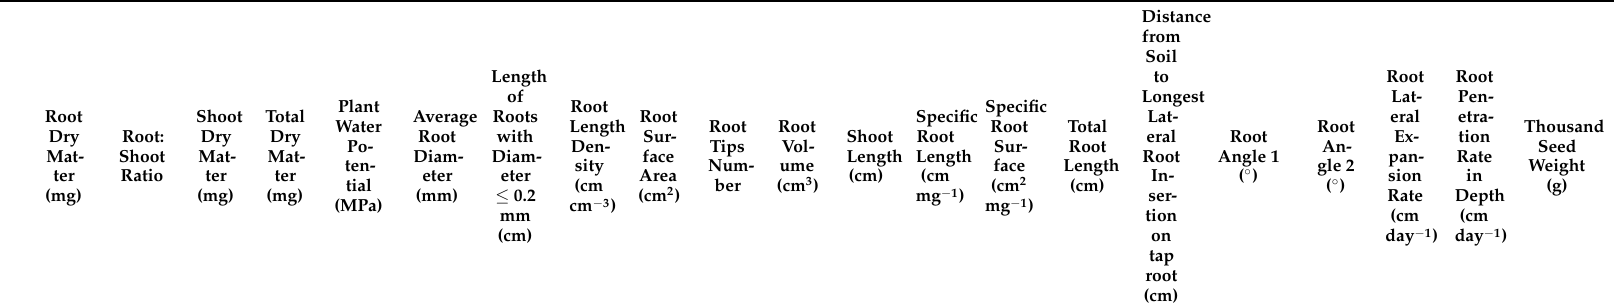
Table A5. Correlation between traits underwater-stressed